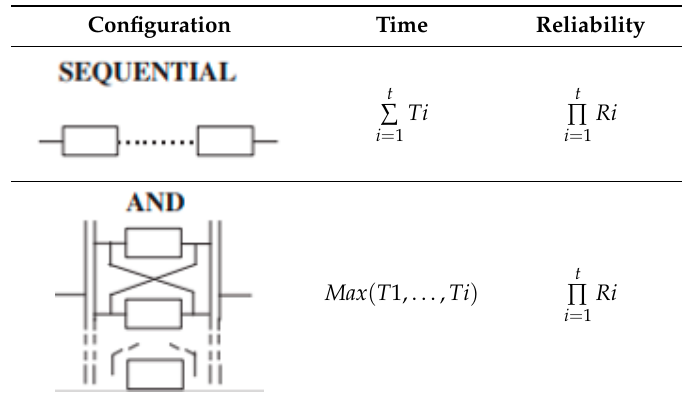
Table 1. Performance aggregation computation.